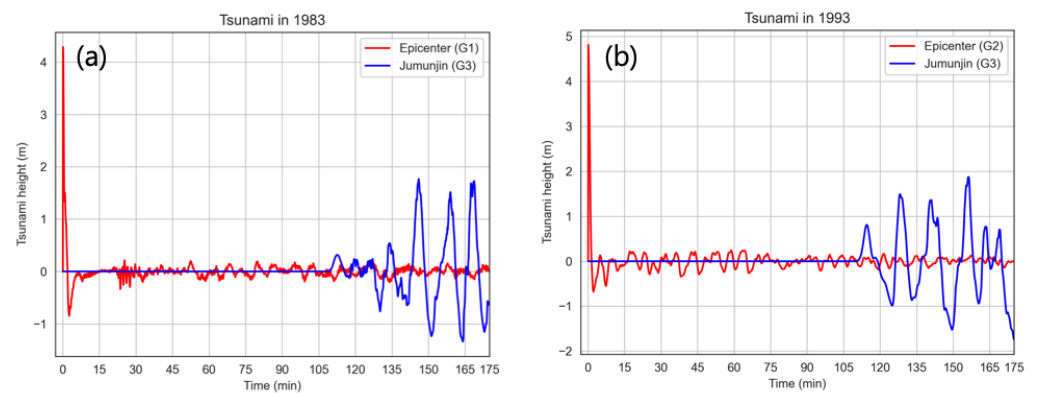
Figure 6. Time series of tsunami heights at epicenter and Jumunjin port by tsunami in ( a ) 1983 and ( b )